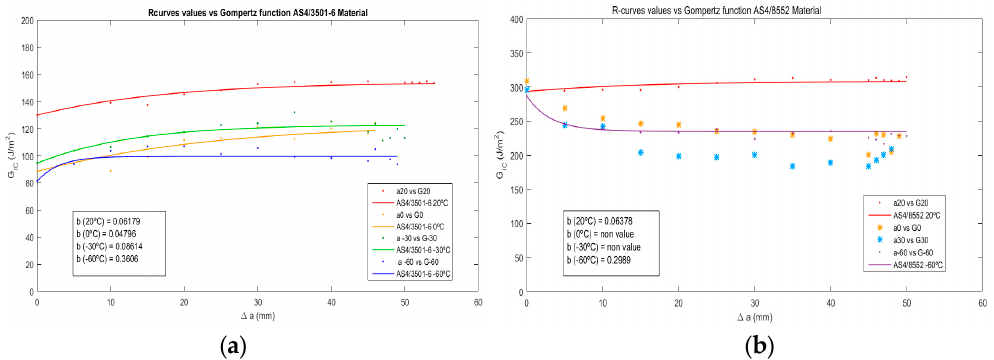
Figure 1. R-curves approximation by the Gompertz function for: ( a ) AS4/3501-6 and ( b ) AS4/8552